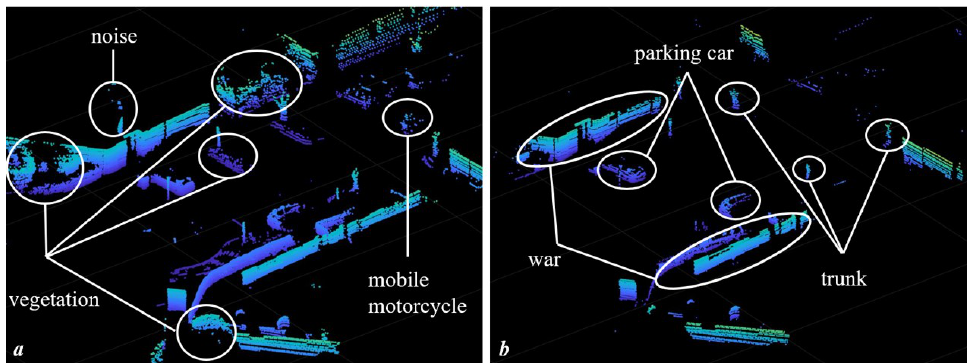
Figure 4. Visualization of the segmentation process. ( a ): original point clouds of one frame. Vege- tation, small moving object, and noise are present. ( b ): segmented point clouds, which shows that unstructured vegetation, noise, etc., are